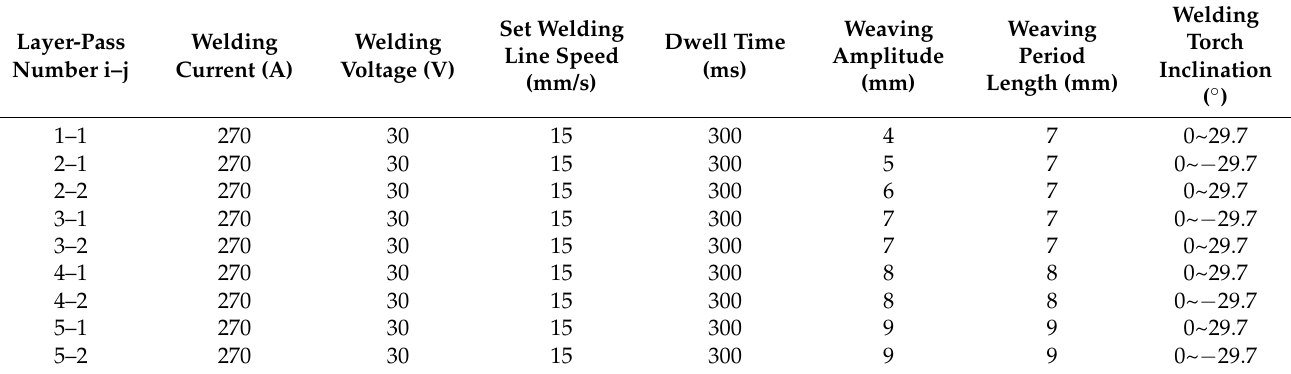
Table 1. Weaving welding